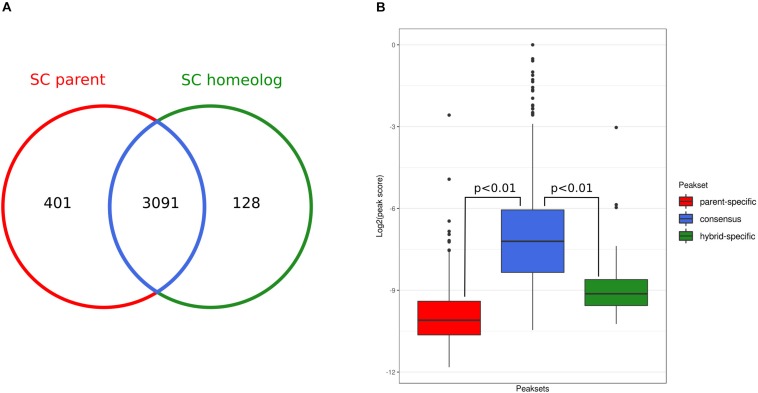
Occupancy analysis. (A) Overlap between ATAC-Seq peak sets detected for the Saccharomyces cerevisiae genome and the corresponding S. cerevisiae sub-genome in the hybrid. (B) Comparison of the distributions of DiffBind peak scores of the parent-specific (red), consensus (blue), and hybrid-specific (green) peaks. P-values are calculated using Wilcoxon test.